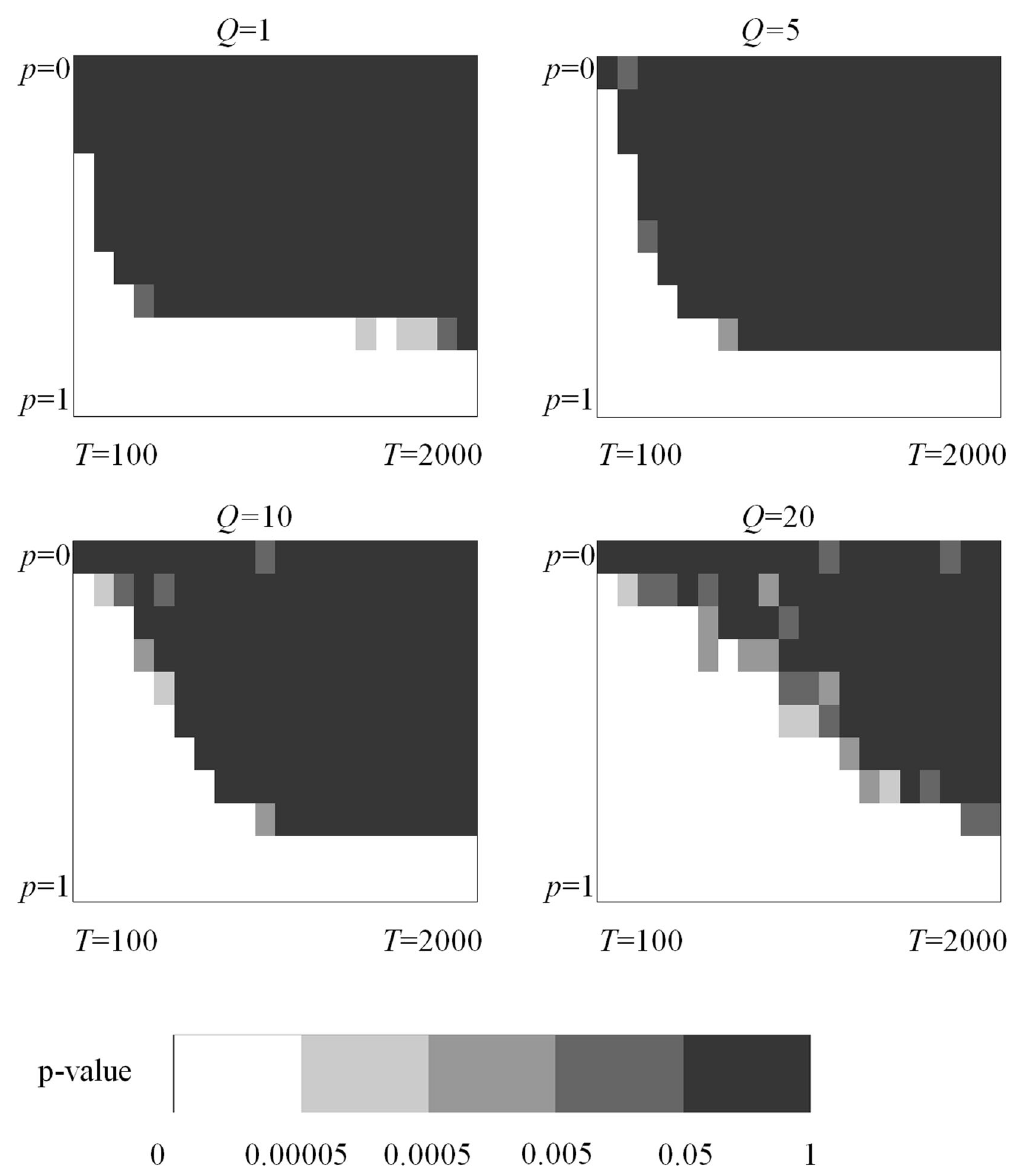
Fig. 11 The effect of the number of resources Q within a patch on model behavior. Explanation of the fi gure is exactly the same as in Fig. 5. In general, more non-black squares appear as Q increases, implying solitary behavior is favored. Values for other parameters are: D = 0.002 , M = 1000, Q = 1, S = 1, E =